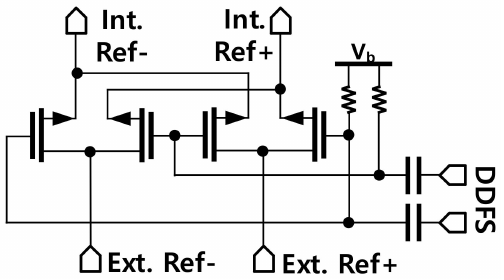
Figure 12. Schematic of the mixer to generate the internal reference frequency for the PLL.